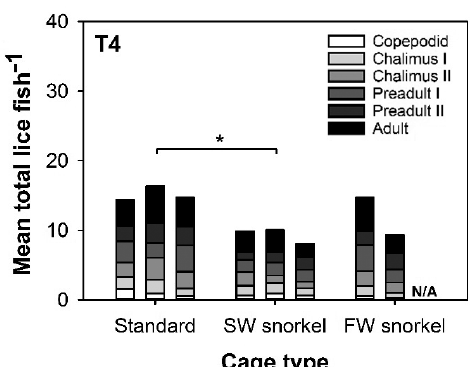
Fig. 3. Mean counts (±SE) of new lice per fish (attached lice or copepodid, chalimus I and chalimus II lice stages) in farmed Atlantic salmon for each replicate standard (white bars), SW snorkel (grey bars) and FW snorkel cage (blue bars) at Times 1−4. See Fig. 1 legend for details of cage treat- ments and sampling times. N/A in - dicates 1 FW snorkel cage discarded from analyses. *p < 0.05, ***p < 0.001